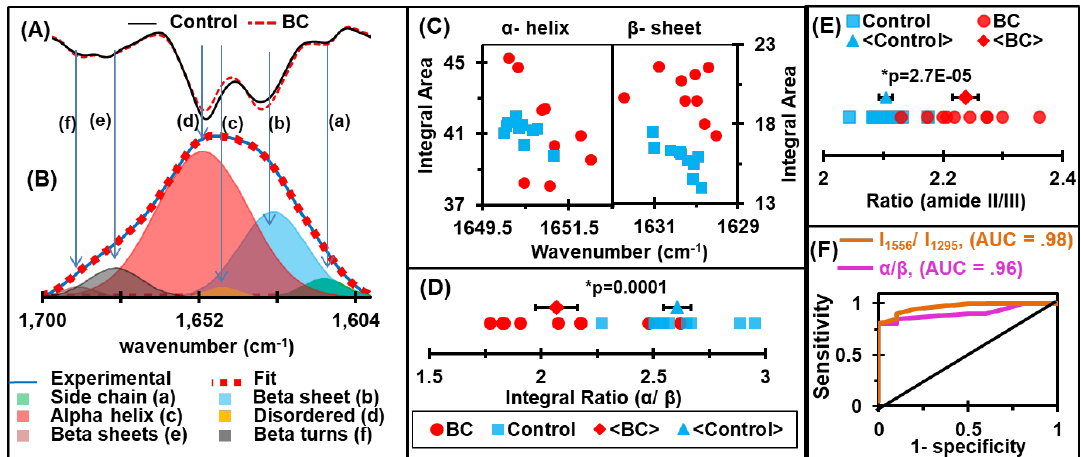
Figure 3. Protein secondary structure analysis. ( A ) Representative second derivatives of absorbance spectra at the amide-I absorbance region. ( B ) Deconvolution of the amide-I region: the baseline-corrected spectra fitted with 6 GFEB by approximating the number and position of the minima of second derivatives, which simulated fits (▪▪▪) to the experimental curve ( ̶ ). ( C ) Integral area of GBEF representing α helix and β sheet. ( D ) The ratio of α helix and β sheet energy bands, which proves an elevation of β sheet and drop off α helix structures due to malignancies. ( E ) The ratio of IR absorbance at amide II (I 1556 ) to its value at amide III (I 1295 ). ( F ) Receiver Operating Characteristic (ROC) curves for the ratio of the integral area of the energy bands representing α-helix and β-sheet protein secondary structures and the respective absorbance at amide II and amide III. The maximum values of sensitivity and specificity are 90% and 90% for signature α/β, while these values are 100% and 80% for signature I 1556 / I 1295 , respectively.